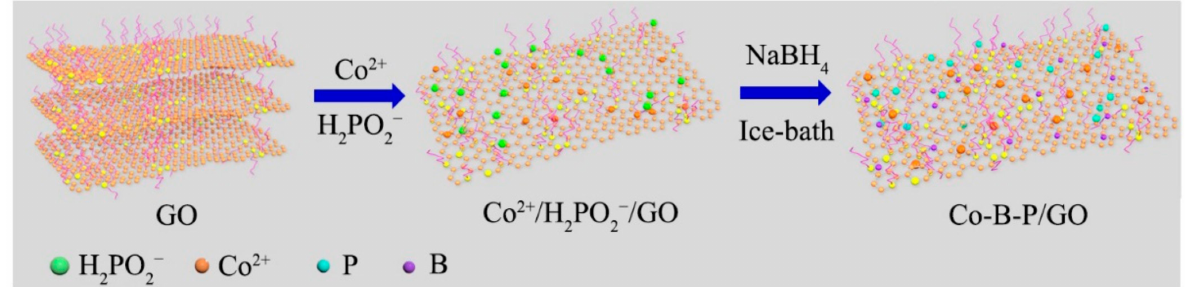
Figure 1. The illustration of the synthetic route of